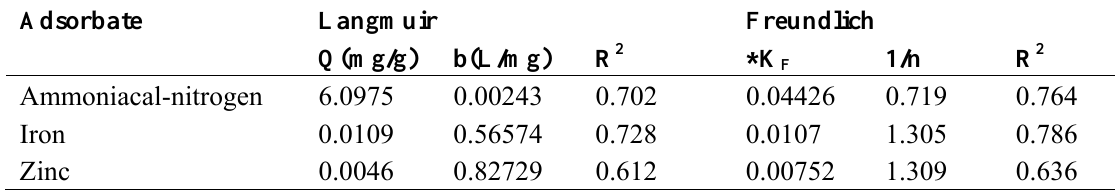
Table 4. Langmuir and Freundlich isotherm constants for adsorption of ammoniacal nitrogen, iron and zinc onto silica